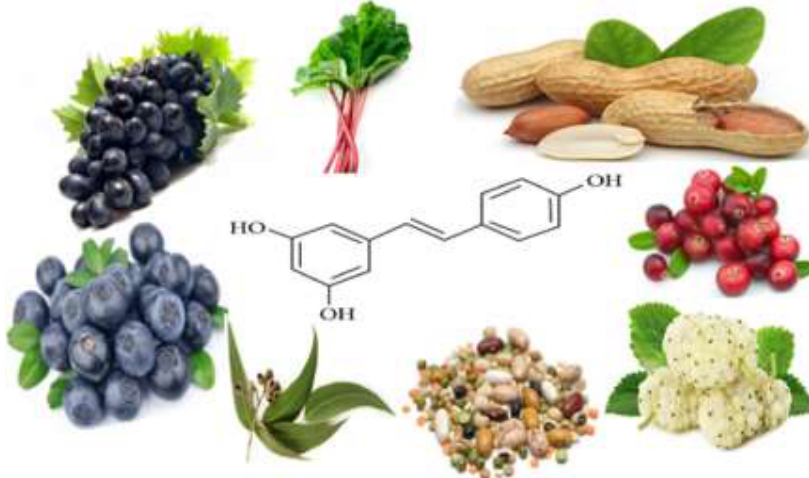
Figure 1: Chemical structure and rich sources of RES [4-6].